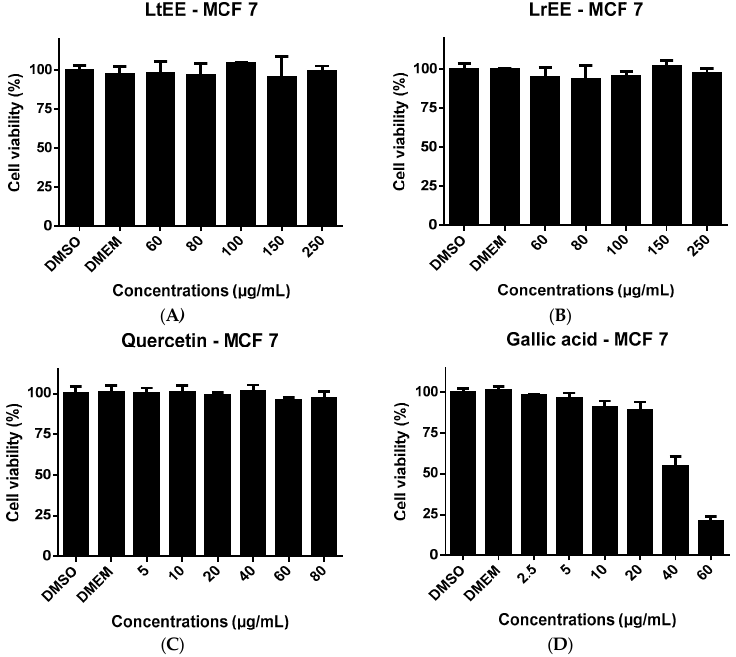
Figure 3. Cell viability of the human breast adenocarcinoma cell line MCF-7 upon 24 h exposure to ethanolic seeds extracts of Licania tomentosa ( A ); L. rigida ( B ); quercetin ( C ) and gallic acid ( D ). DMSO, dimethyl sulfoxide; DMEM: Dulbecco's Modified Eagle's Medium; LrEE: L. rigida ethanolic extract; LtEE: L. tomentosa ethanolic